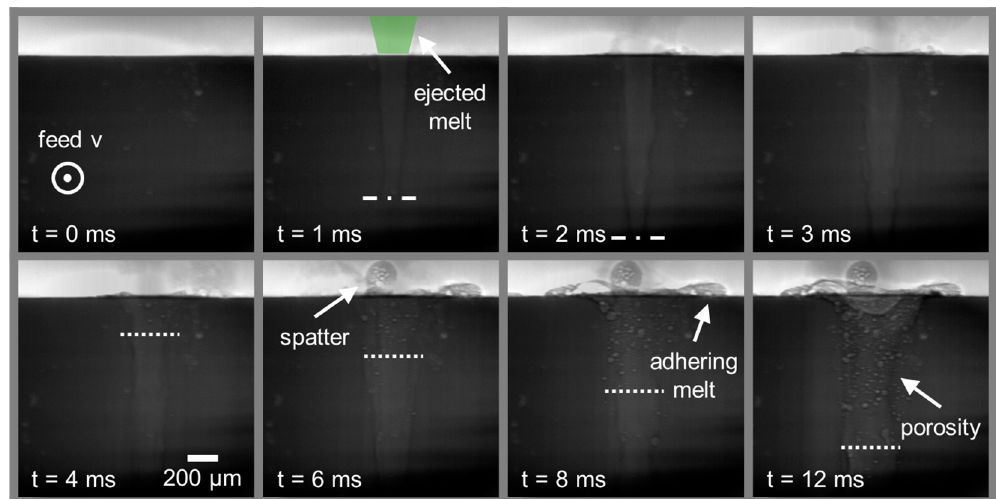
Figure 9. X-ray video sequence of laser beam welding of copper using 515 nm laser radiation, P = 3000 W, v = 66.7 mm/s. P = 3000 W, v = 66.7